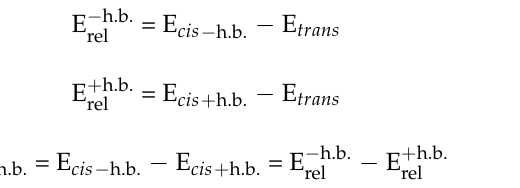
, E + h.b. , ∆ E h.b. all in kcal mol − 1 ) computed with the TZ rel rel